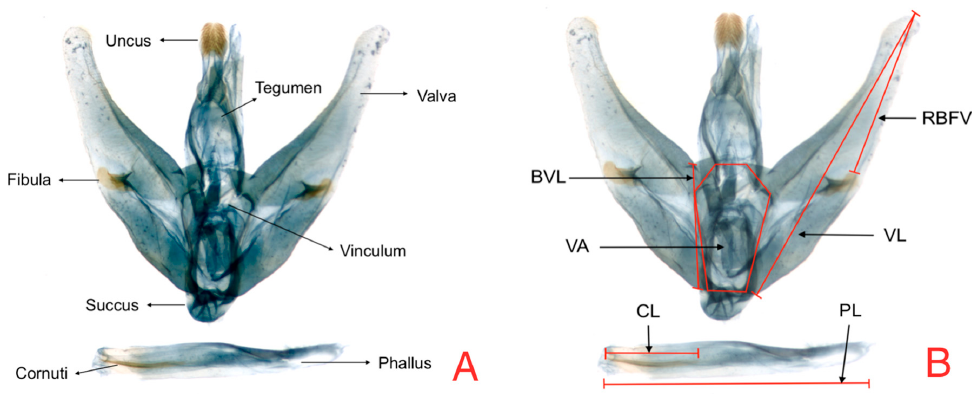
Figure 2. Male genitalia ( A ) Anatomic structures ( B ) Measures: PL = phallus length CL = cornuti length; VL = valva length; VA = Vinculum area; RBFV = ratio of the fibula position in the valve; BVL = basal valva length.